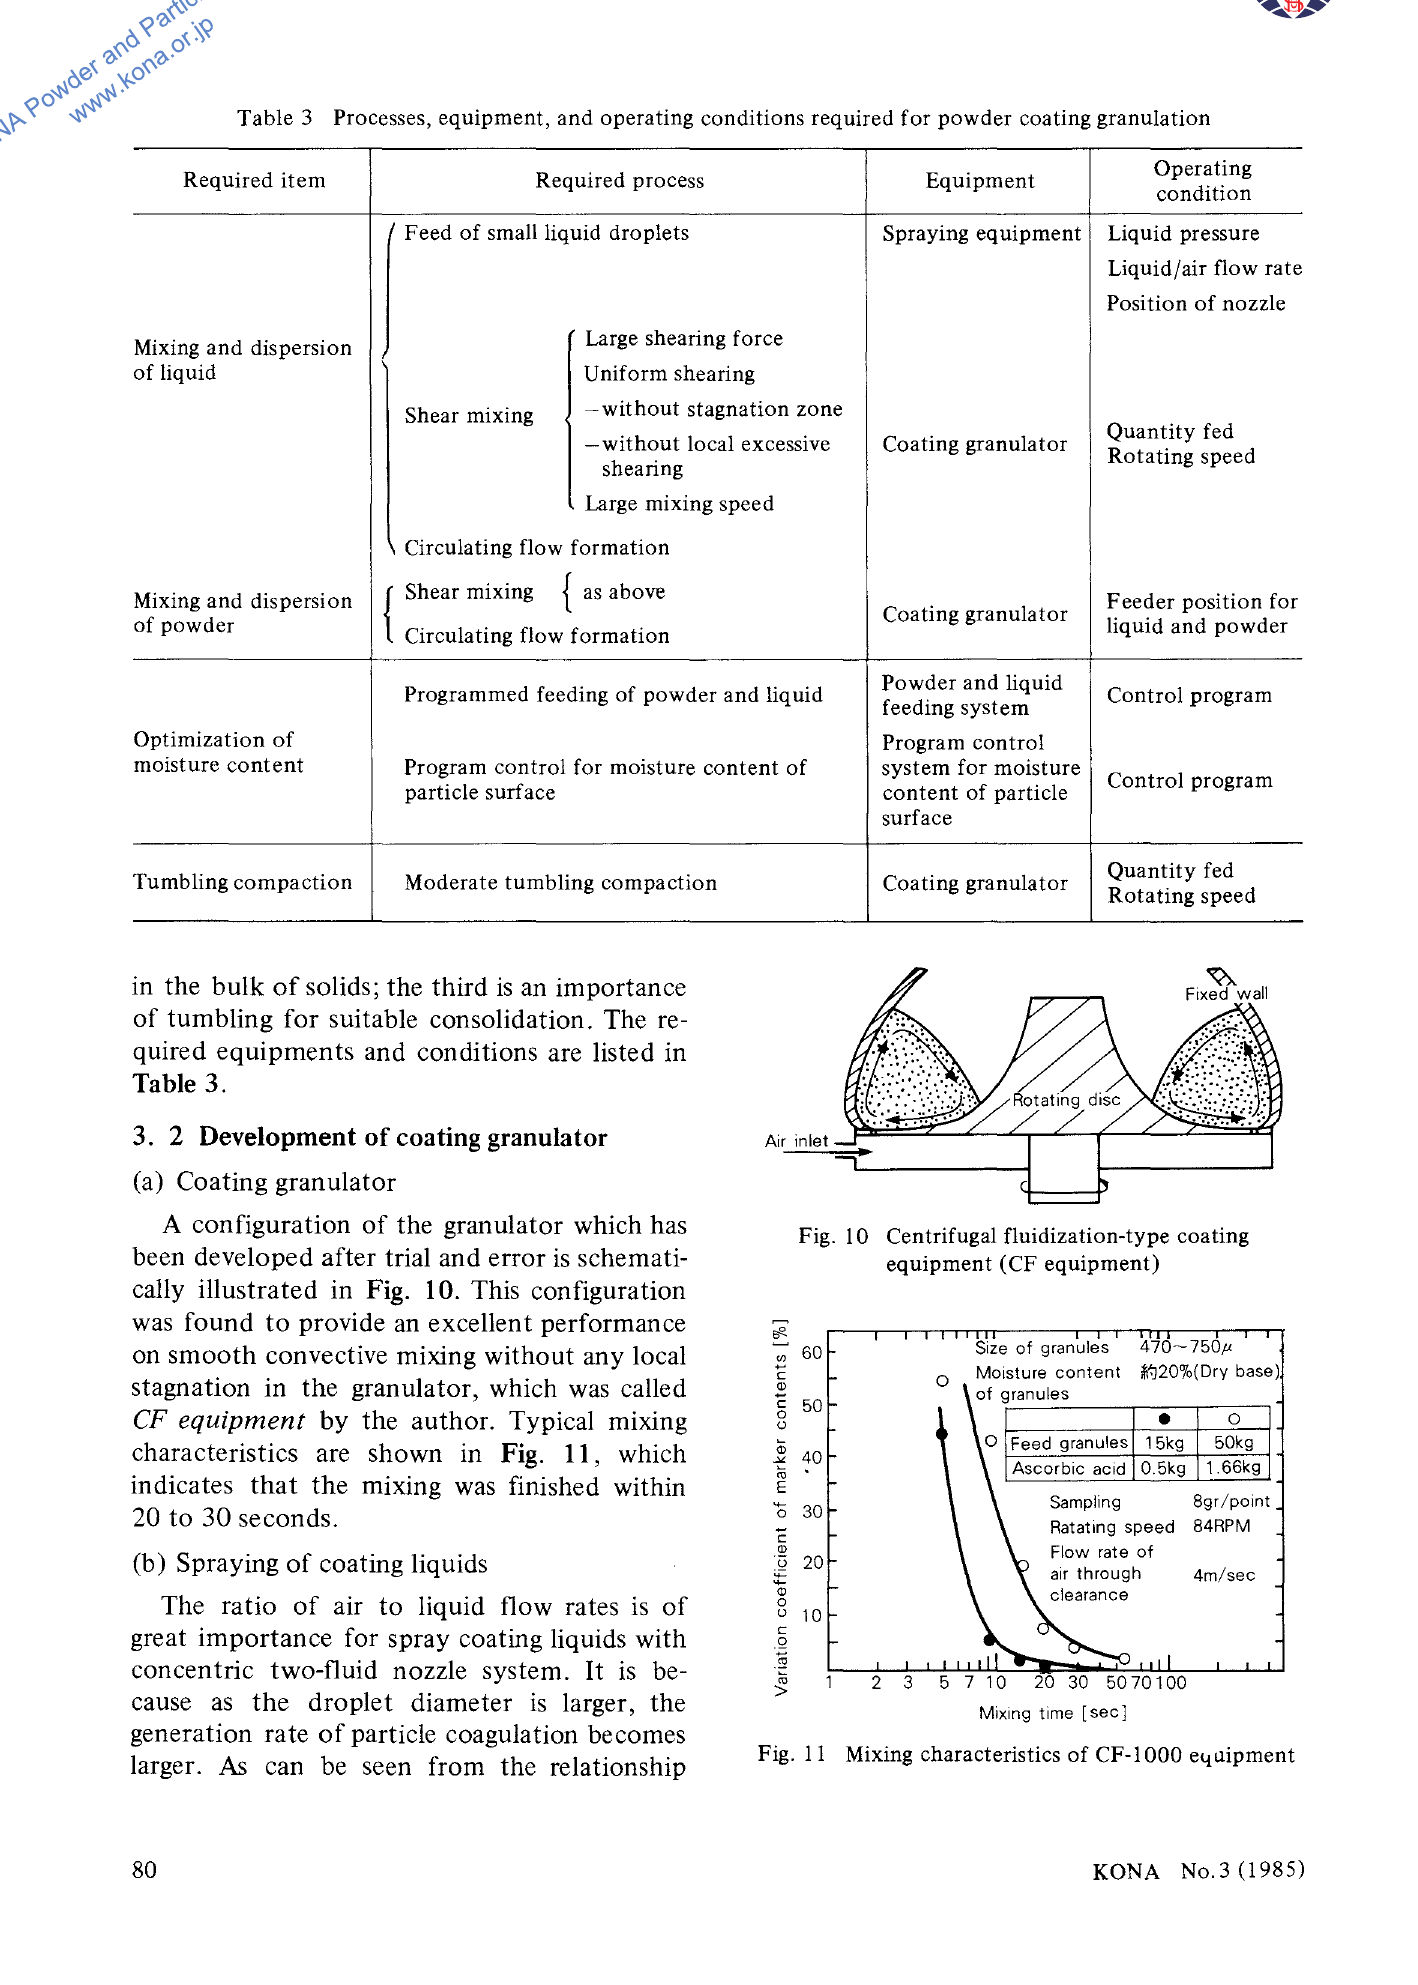
Table 3 Processes, equipment, and operating conditions required for powder coating granulation